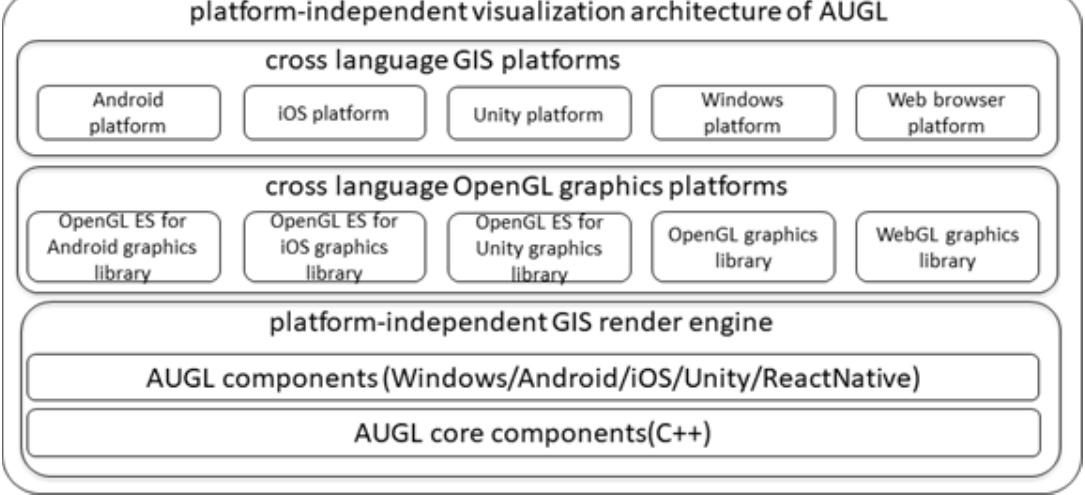
Figure 1. Platform-independent visualization architecture of